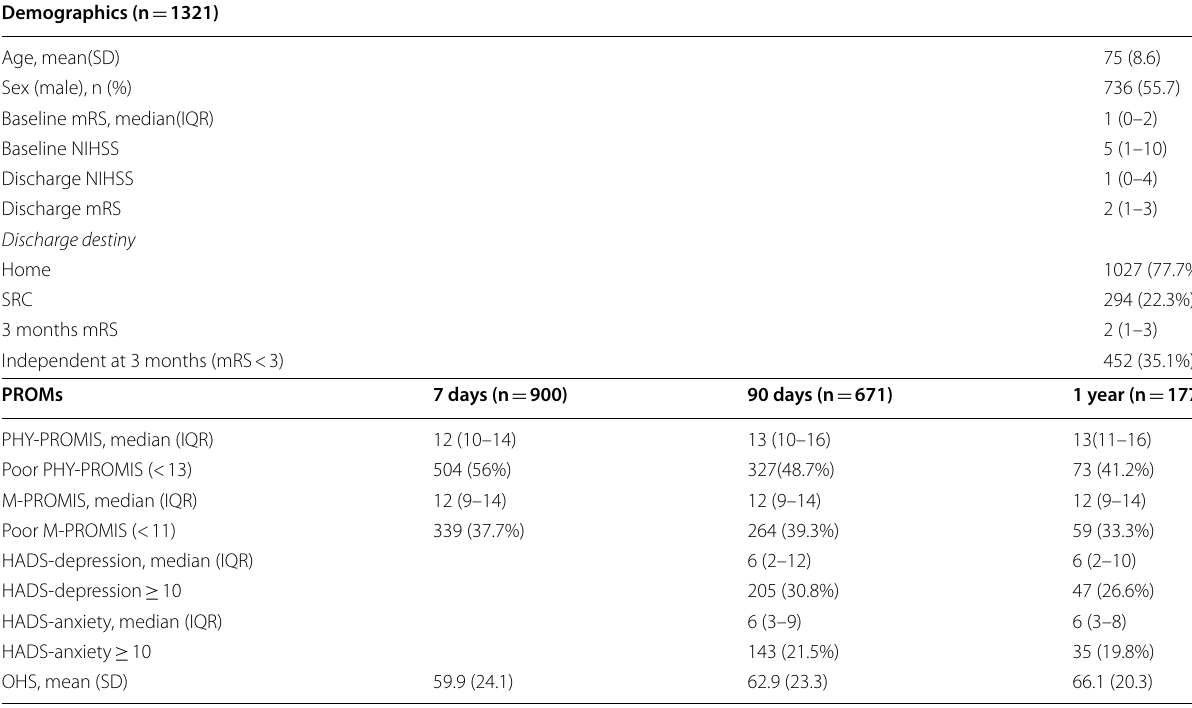
Table 1 Baseline clinical characteristics and main PROMs